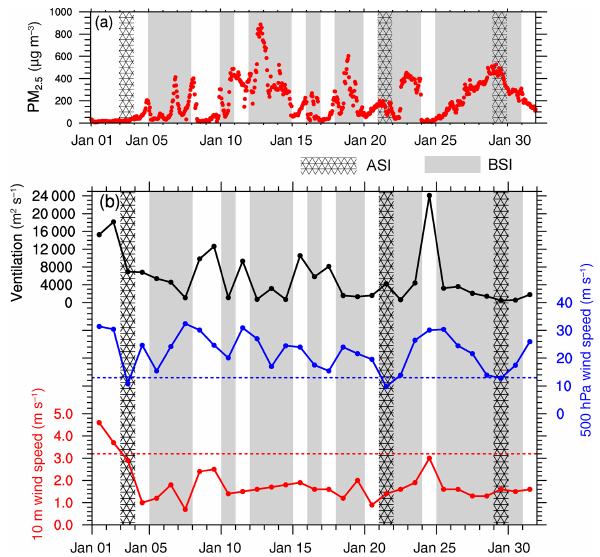
Figure 13. Time series of the ASI and BSI with hourly concen- tration of PM 2 . 5 during January 2013 of Beijing (a) , and the corre- sponding variation of the main components of the ASI and BSI, i.e., daily ventilation and 500hPa and 10m wind speeds (b)